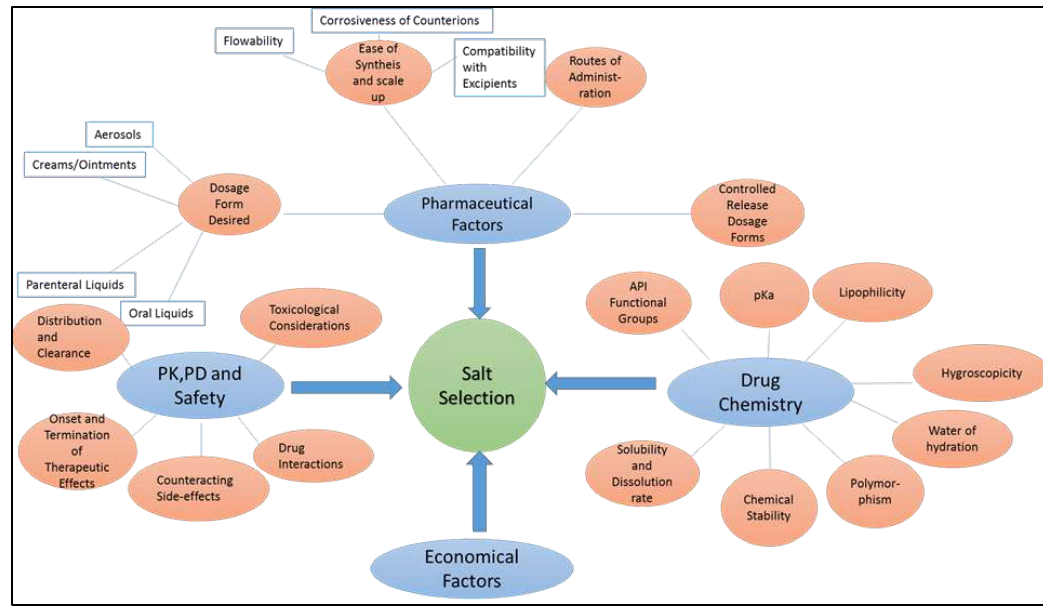
Figure 4. Various factors affecting the salt selection process.